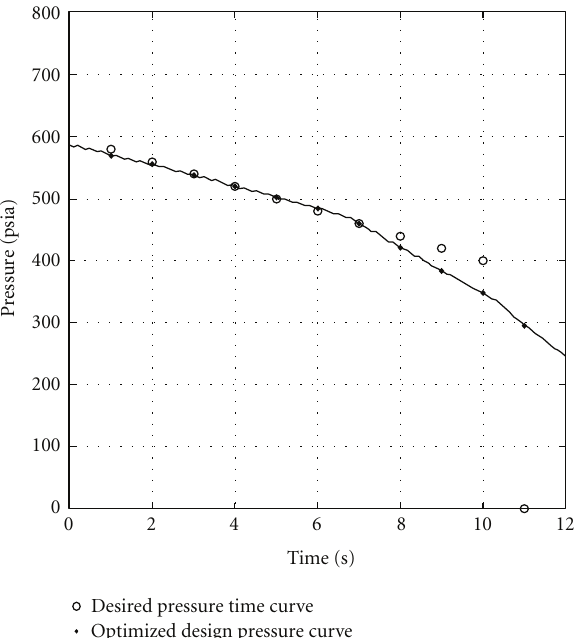
Figure 14: Optimized pressure-time curve for linearly regressive CP grain.